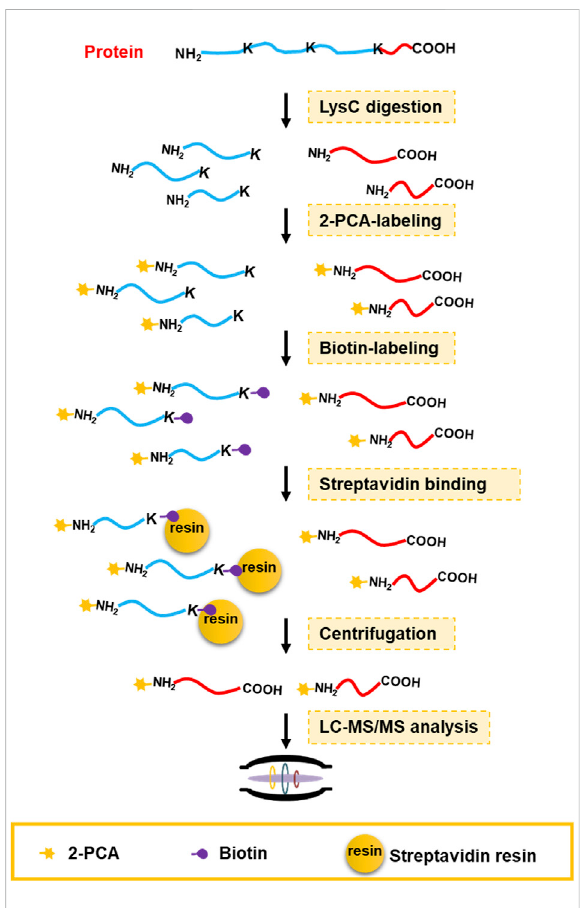
FIGURE 1 C-terminal peptide enrichment work fl ow through the PBC strategy. The extracted whole cell proteome is digested into peptides by LysC protease. Then the LysC-digested peptides are tandemly reacted with 2-PCA and NHS-biotin. Next, the peptides with biotin-labeled lysine were captured by streptavidin beads. Finally, the C-terminal peptides are enriched by fi lter-aided separation from streptavidin beads and detected by